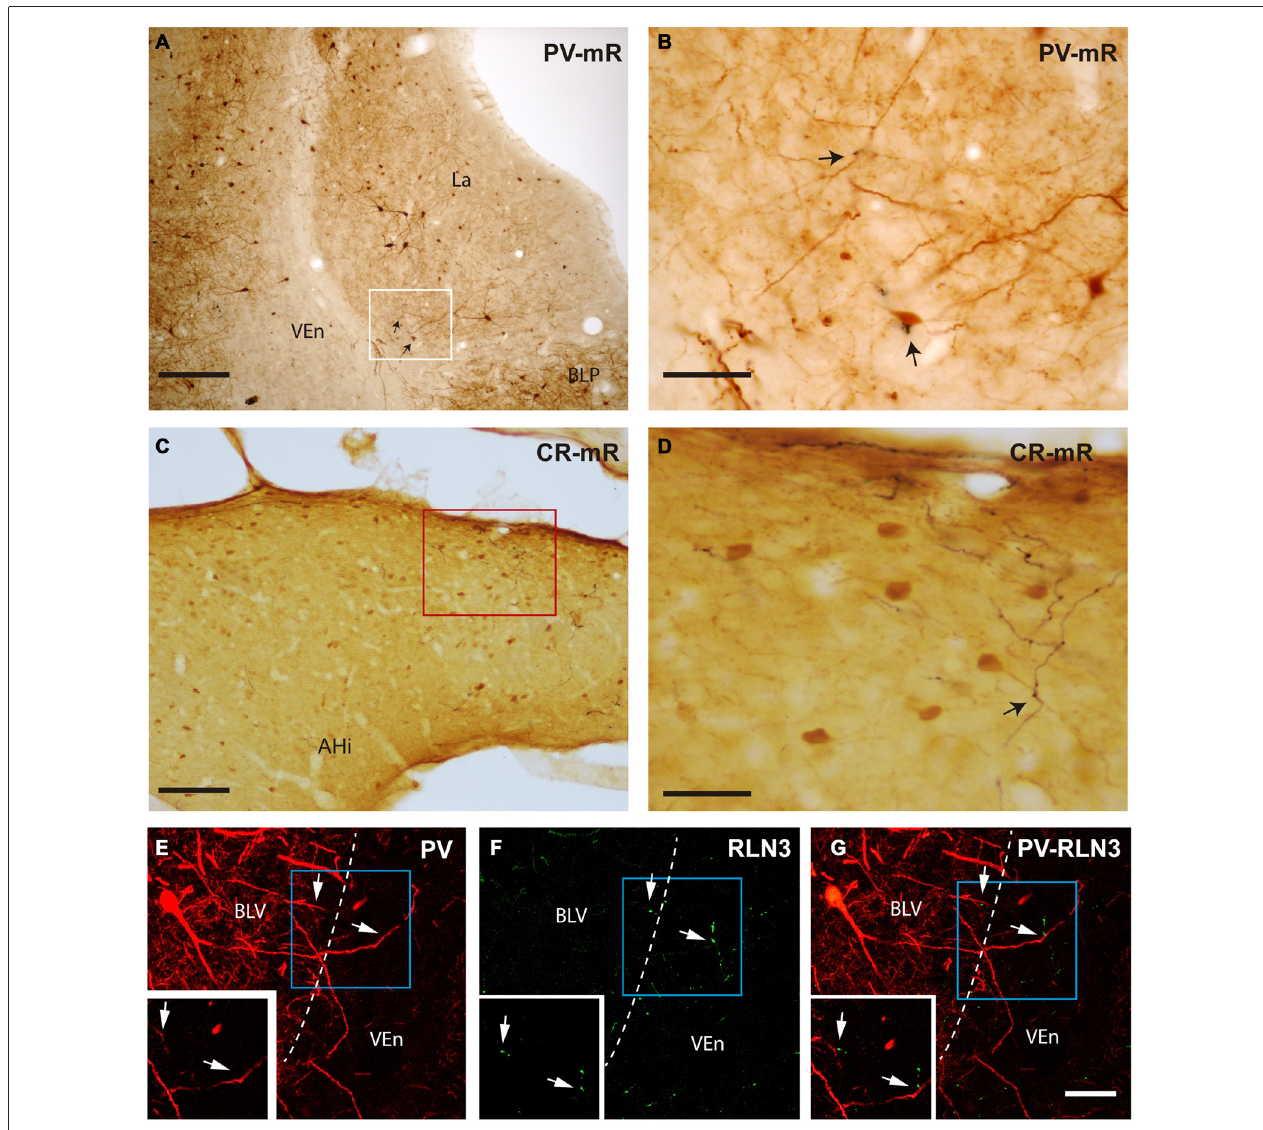
FIGURE 10 | Close apposition between mR anterogradely-labeled NI fibers or relaxin-3-positive fibers and PV-positive or CR-positive neurons. (A) Posterior lateral amygdala region (containing mR-positive elements and neurons stained for PV (case sf2). (B) Higher magnification of the area labeled in (A) representing a close contact between an anterogradely labeled fiber (black) and the soma of a PV-positive neuron. (C) Anterograde labeling was abundant in the caudal aspects of the amygdala, particularly in the amygdalohippocampal transition area. (D) Some of the anterogradely-labeled elements contacted CR neuron processes (arrow; case sf3). (E–G) Confocal images illustrating contacts between relaxin-3 fibers and PV dendrites in the basolateral ventral nucleus (BLV). The main images represent the maximal projection and the insets a single 0.3 µ m stack. Some dendrites of these neurons extend beyond the boundaries of the nucleus,